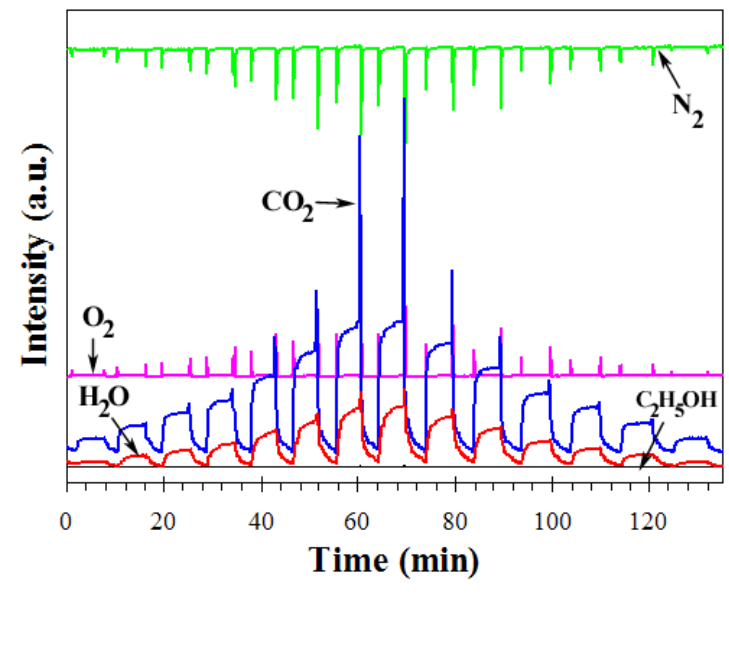
Figure 12. MS ion intensity as a function of time during ethanol oxidation in dry air at 400°C (25-250 ppm) over a sensor S1 sensing